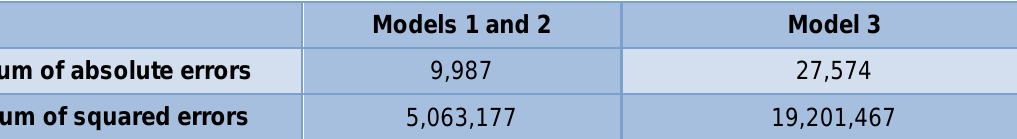
Table 2 Sum of absolute / squared errors of the forecasting values